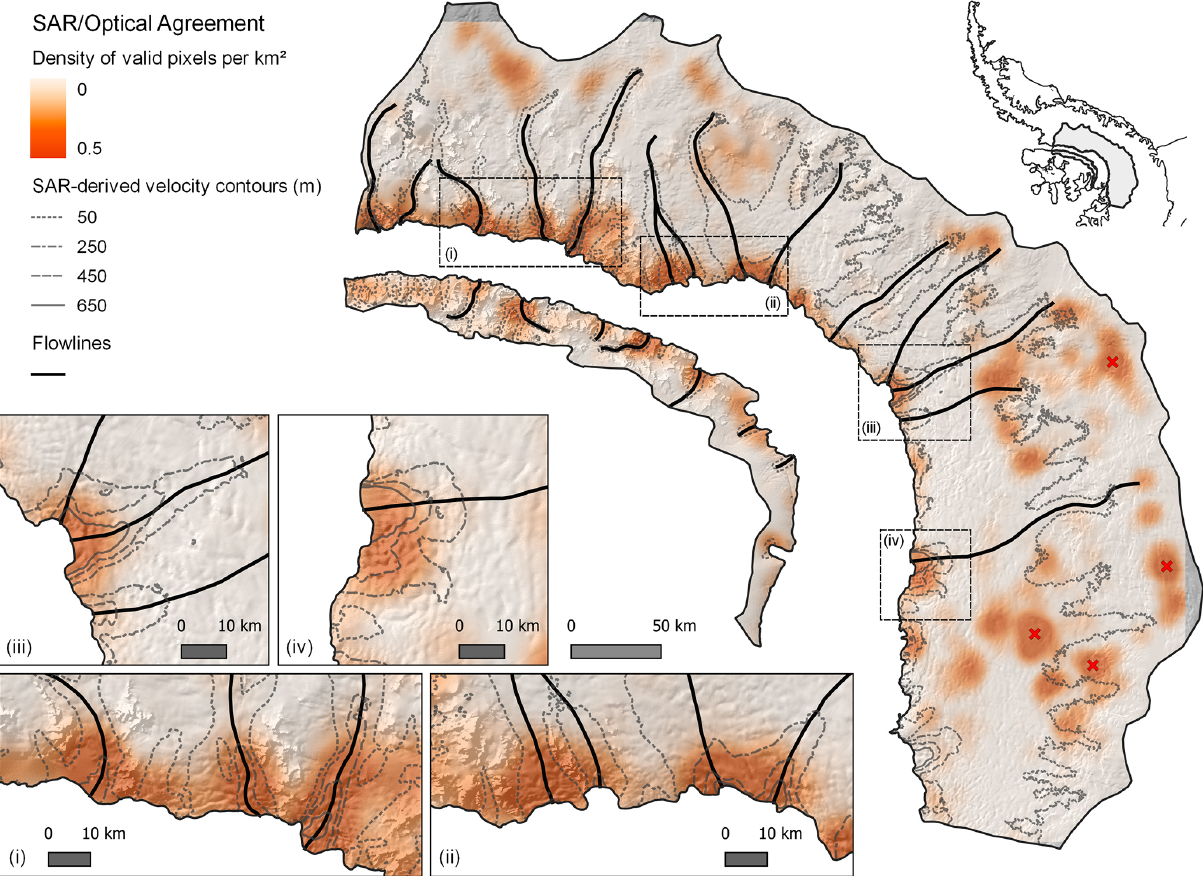
Figure 7. Heatmap indicating the spatial coherence of seasonal ice-flow variability observed by both SAR and optical imaging techniques. Warmer colours denote a higher density (per km 2 ) of pixels having undergone speed-up of comparable magnitude ( ± 10myr − 1 ) during austral summertime, as observed in both our SAR-derived ( v anom ) and optically derived ( v anom ) records (Sect. 3.3.3). Contours SAR_day OLI are derived from our SAR-derived, time-series-averaged velocity observations (Sect. 3.2). Background DEM is derived from the Reference Elevation Model of Antarctica (Howat et al., 2019). Dashed boxes denote the location of the inset boxes (i–iv). Inset map shows the location of GVIIS’ drainage basins. Red crosses represent examples of areas of clustering not representative of a true geophysical